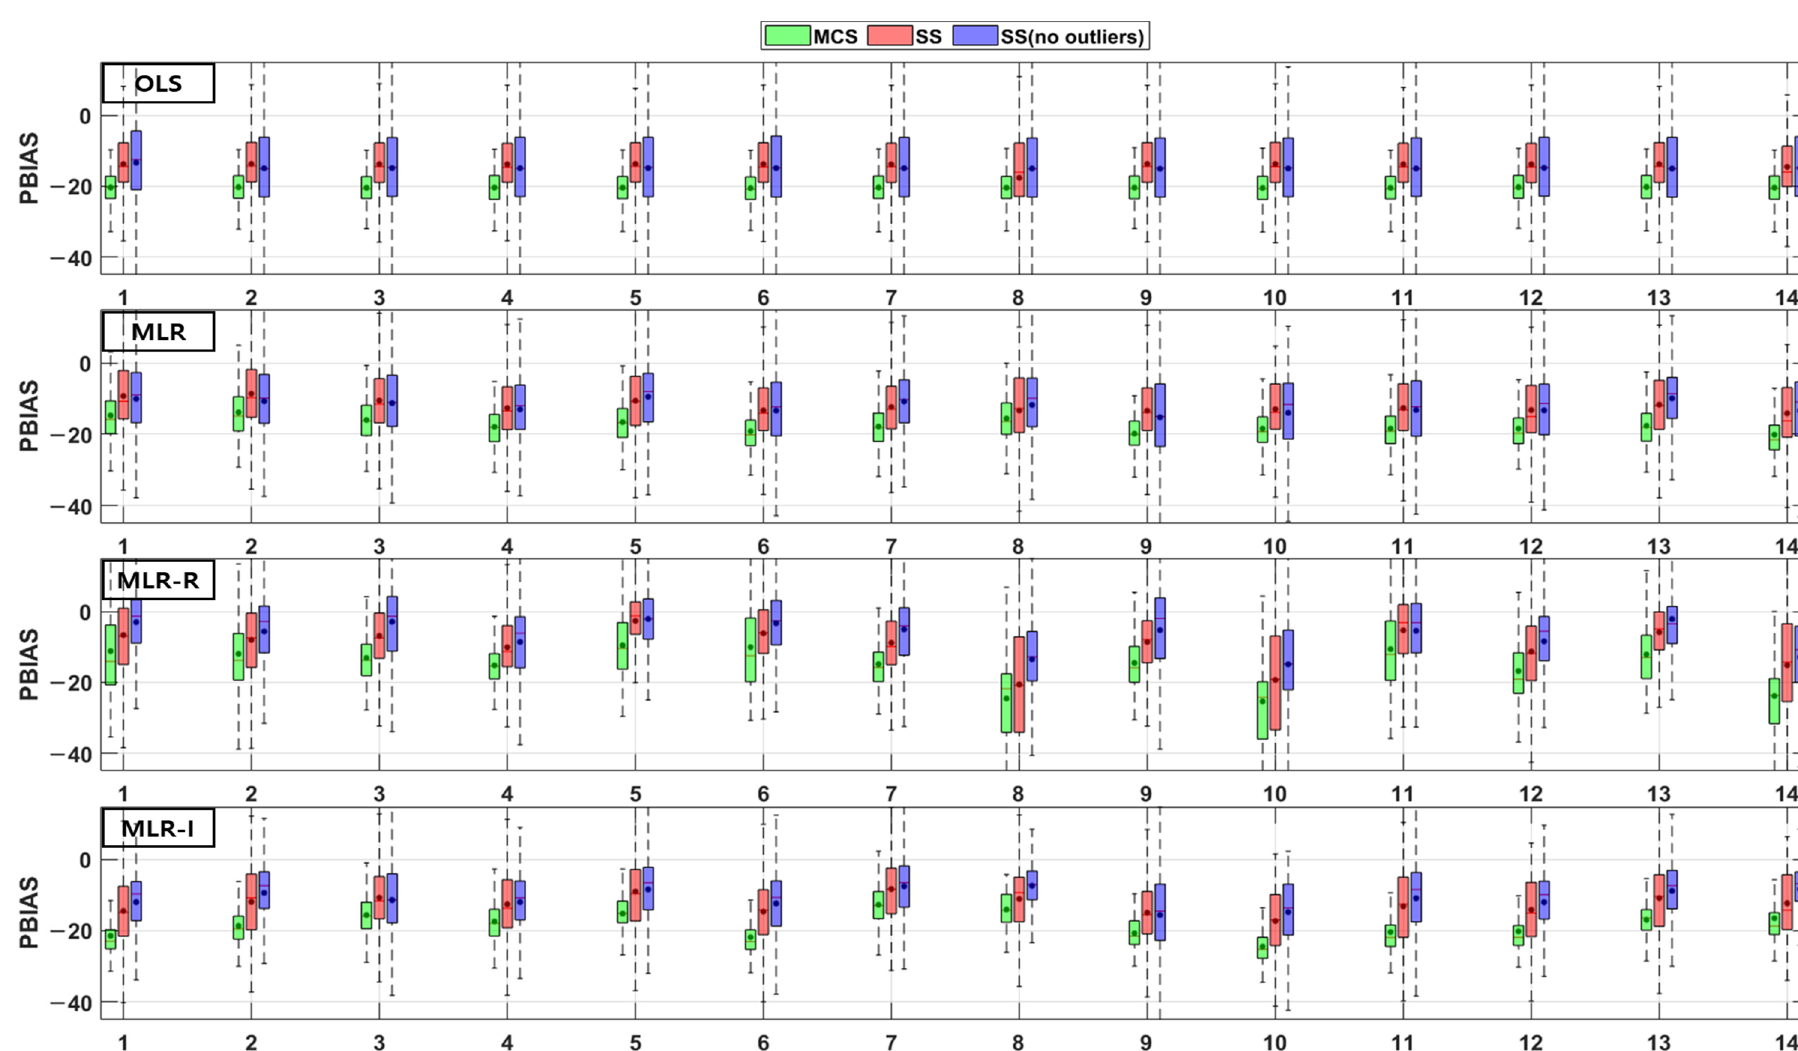
Figure 13. Error analysis (PBIAS) results of TP removal in retention ponds.